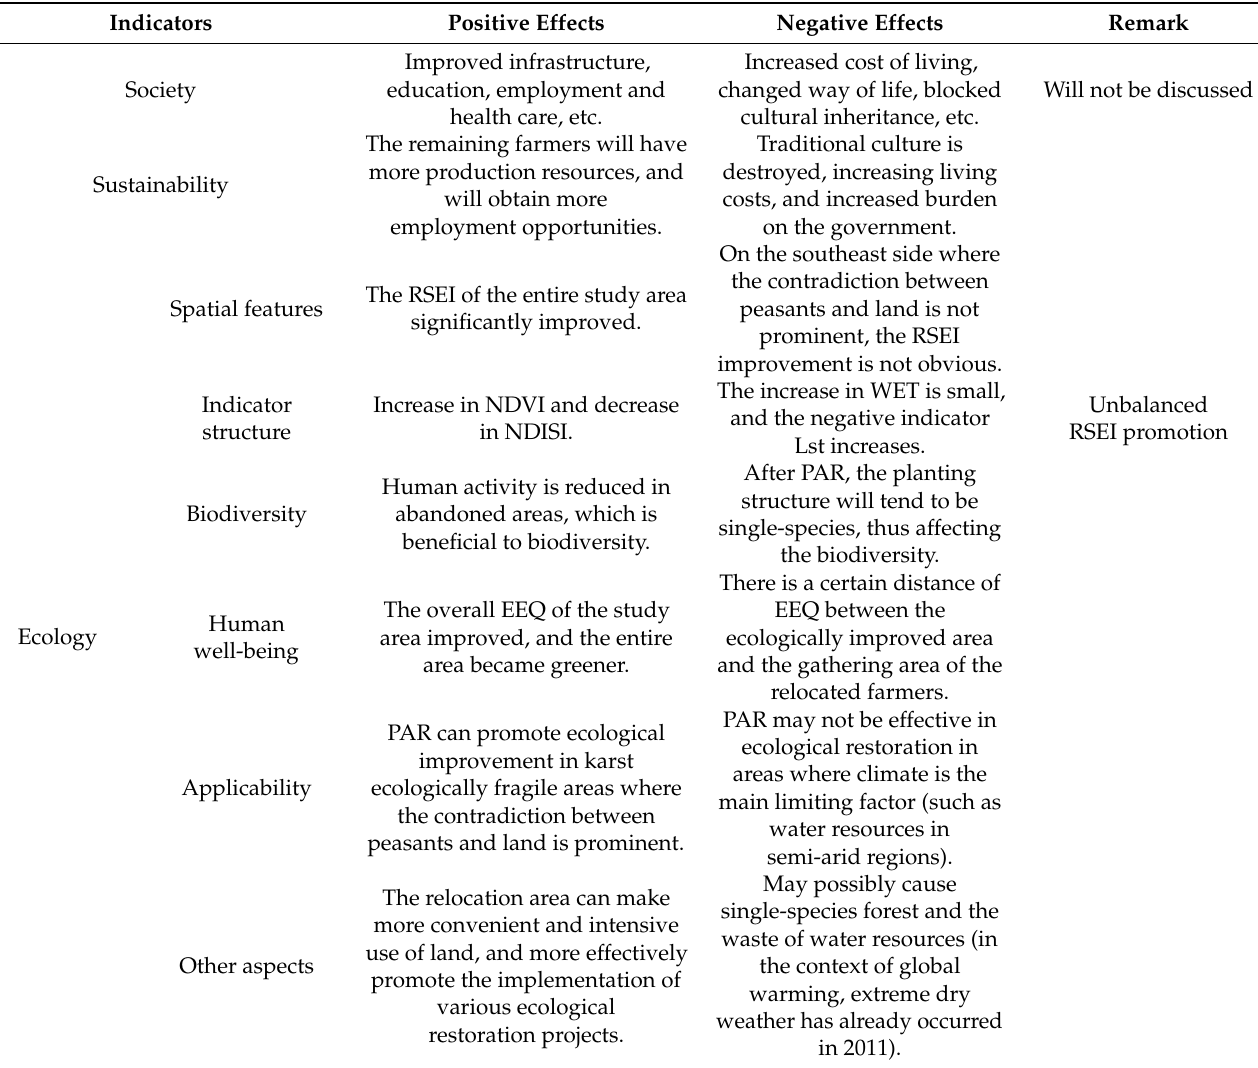
Table 5. Summary table of positive and negative effects of